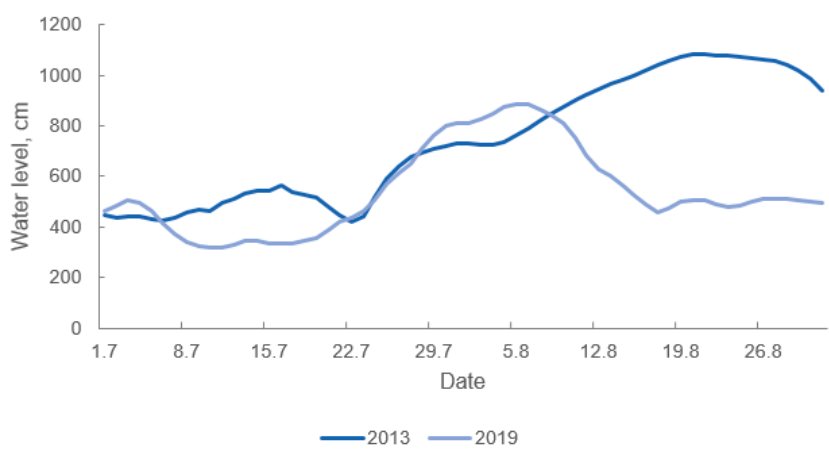
Figure 9. Water level of the Amur River at Innokentyevka stream gauge used to be higher for a major high-water period in 2013 as comparing with in 2019.